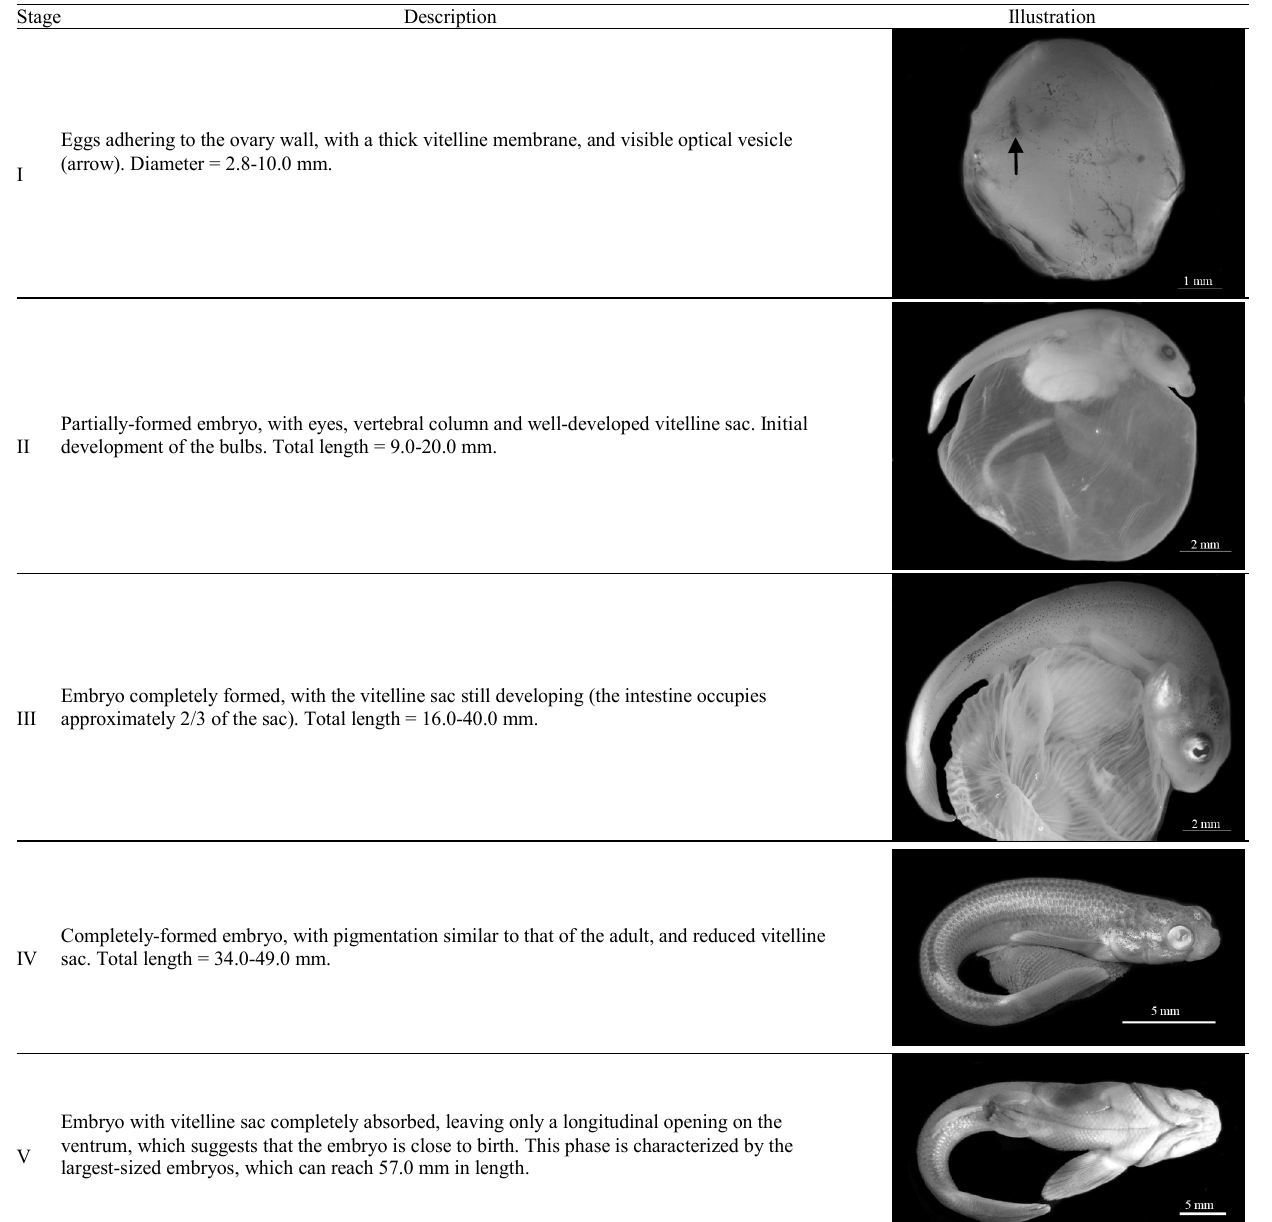
Table 2. Classification of the embryonic stages in Anableps anableps